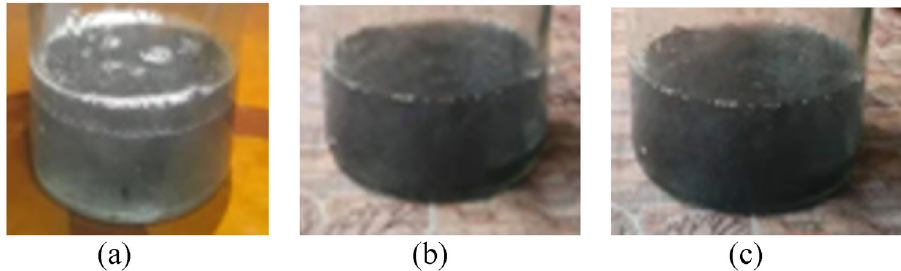
Figure 9: Di ff erent length CF dispersing in PVA solution: ( a ) 3 mm, ( b ) 6 mm, and ( c ) 10 mm.